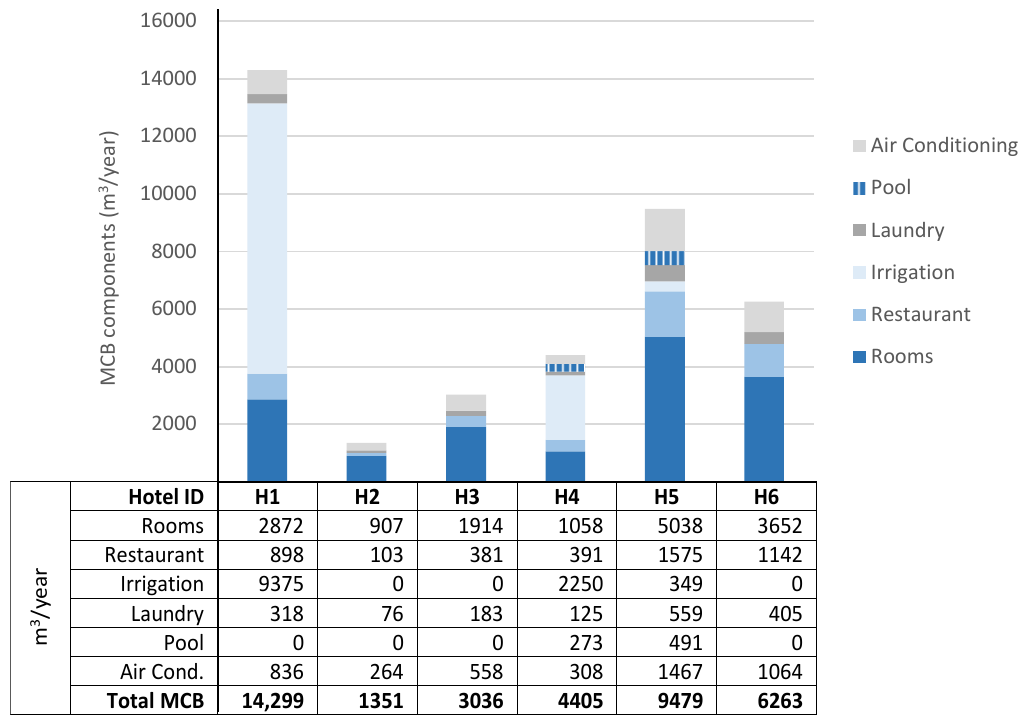
Figure 5. Micro-components for the calculation of MCB for all six hotels in year 2017.